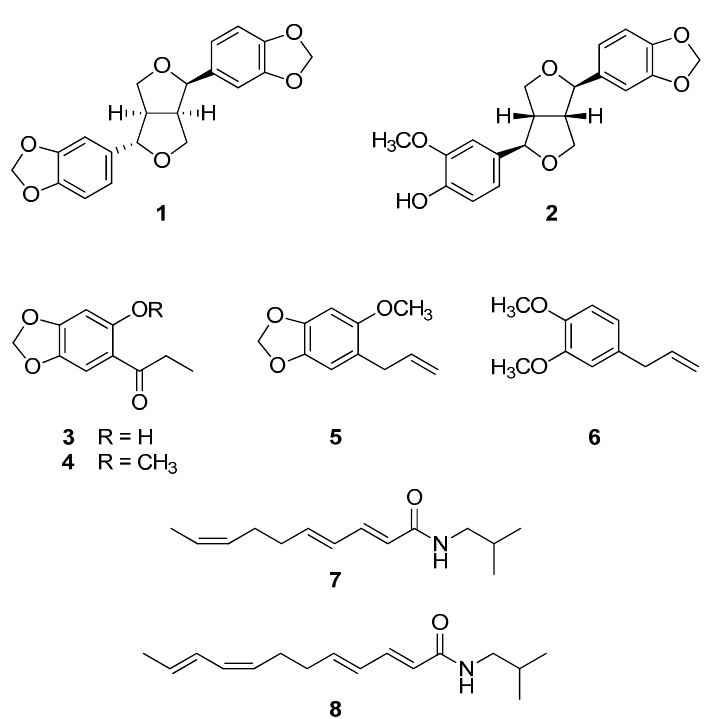
Figure 1. Compounds 1 – 8 isolated from the EtOAc-soluble fraction of the roots of A. sielboldii.